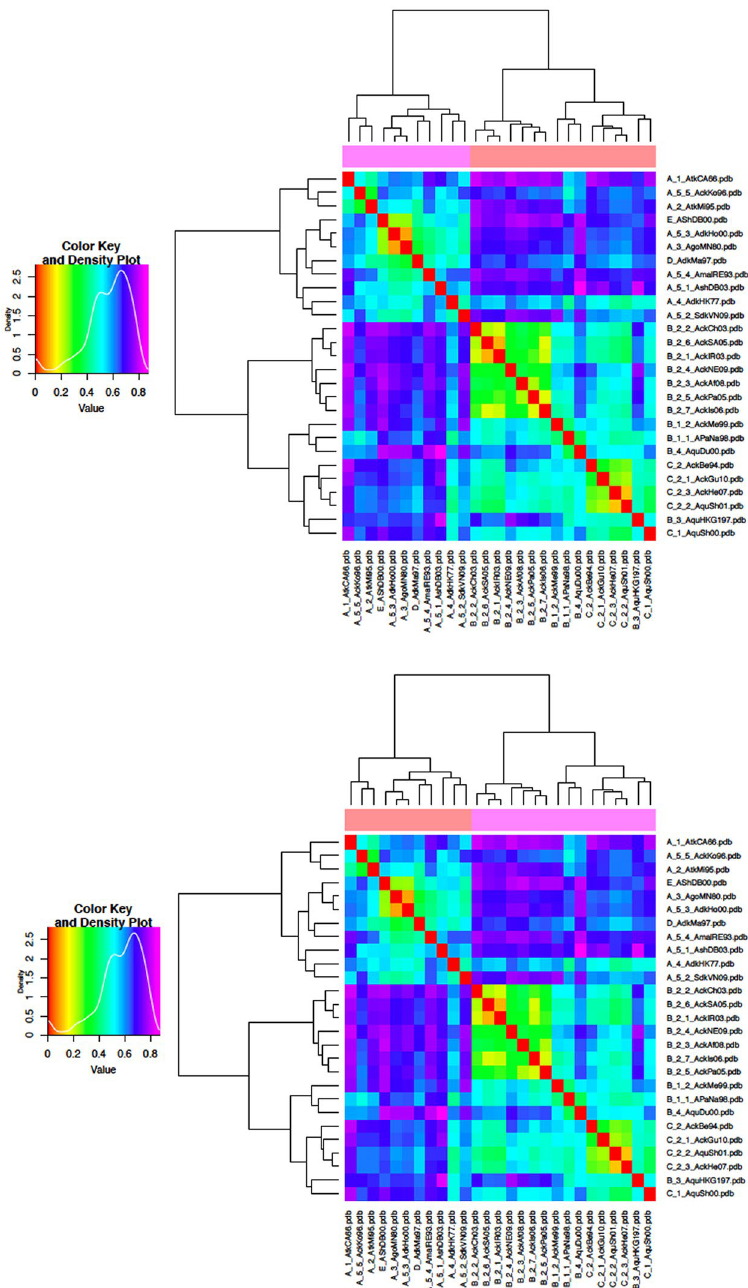
Figure 1. Clustering of representative H9N2 HA RBDs by ED. Density plots (left side) and heatmaps (right side) were calculated using both the Carbo (upper panel) and Hodgkin (lower panel) indexes. Warm (red) to cold (violet) colour transition corresponds to increasing